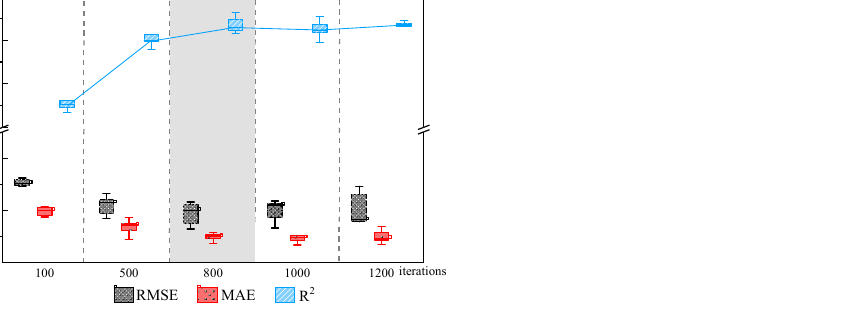
Figure 5. Evaluation indexes of prediction accuracy of ANN model under different iteration times.